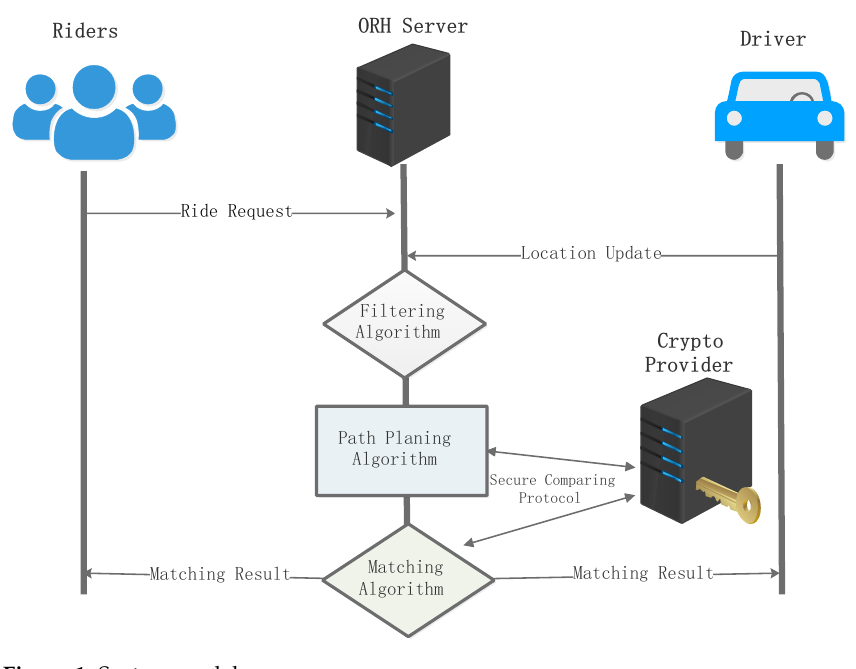
Figure 1. System